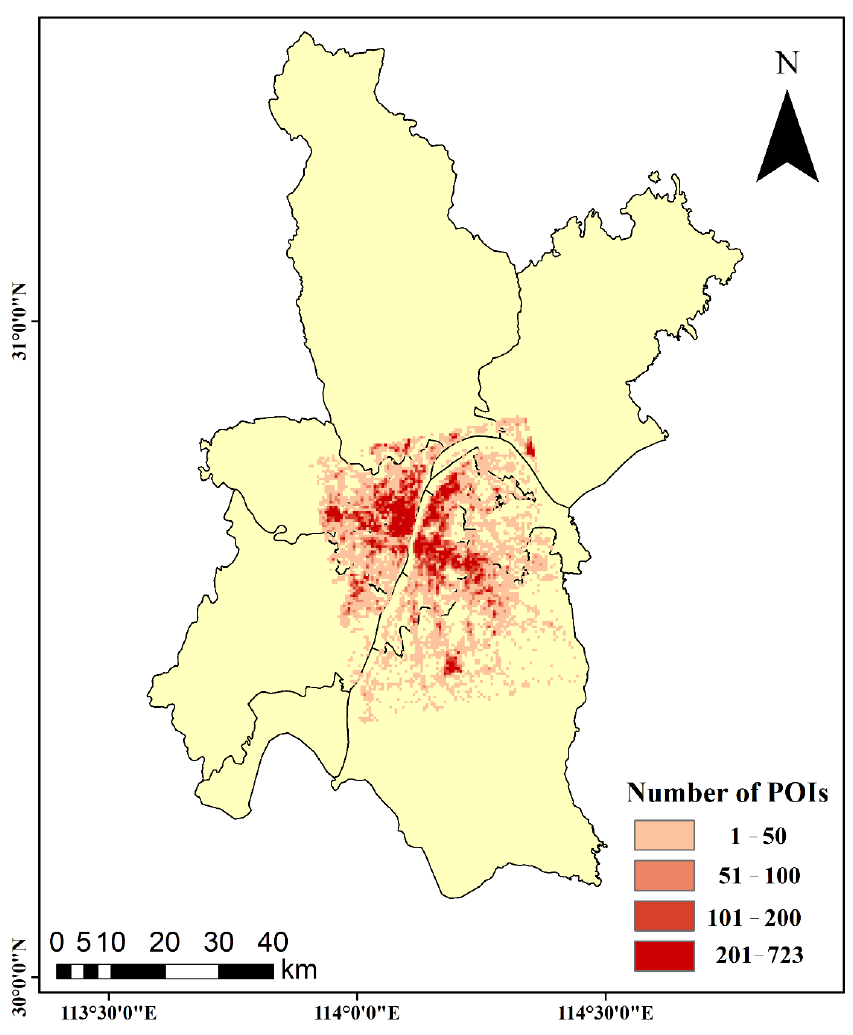
Figure 2. POIs of Wuhan in 2018 at the pixel